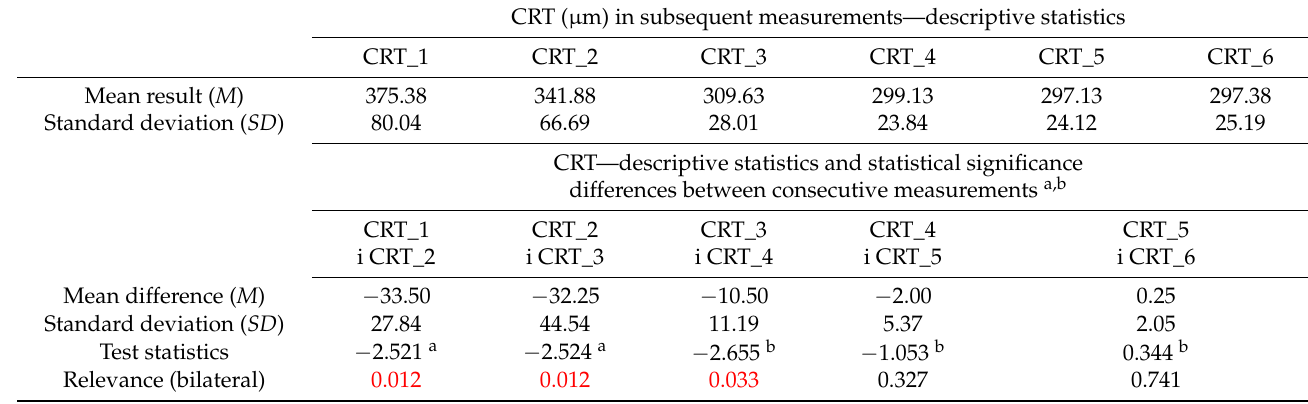
Figure 1. Changes in BCVA in subsequent measurements. Colour indicates statistically significant differences between two consecutive measurements. The change in central retinal morphology as seen on OCT (B-scan) in individual patients on day 1 of injection and day 97 (endpoint) is shown above. Table 3. CRT—descriptive statistics and statistical significance of